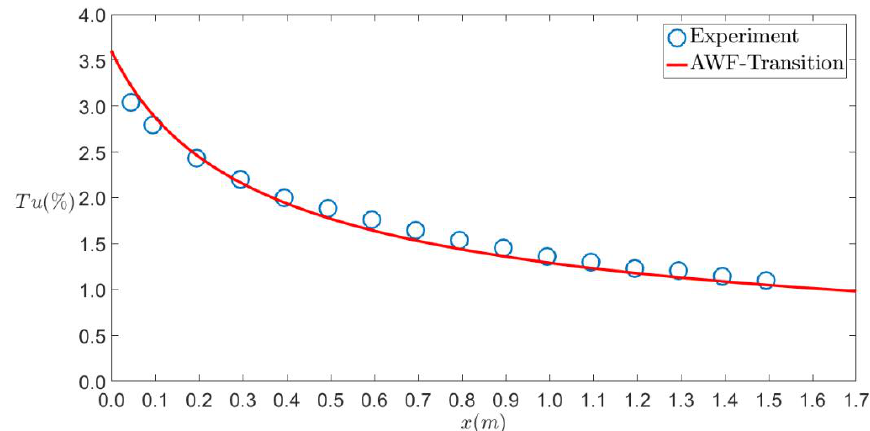
Figure 3. Decay of free-stream turbulence intensity of T3A.